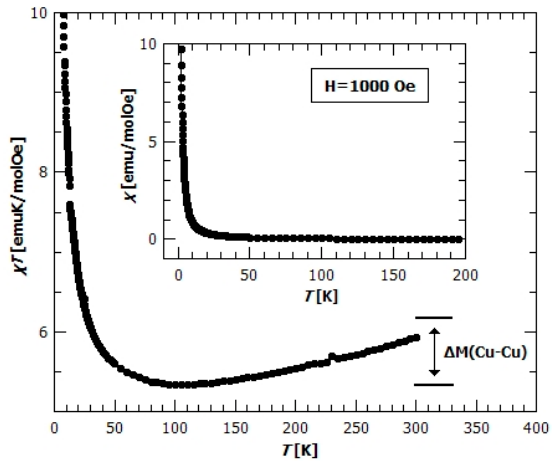
Figure 9. Temperature dependence of χ T for the compound 2 in the field of 1000 Oe. Inset: temperature dependence of susceptibility in 1000 Oe.